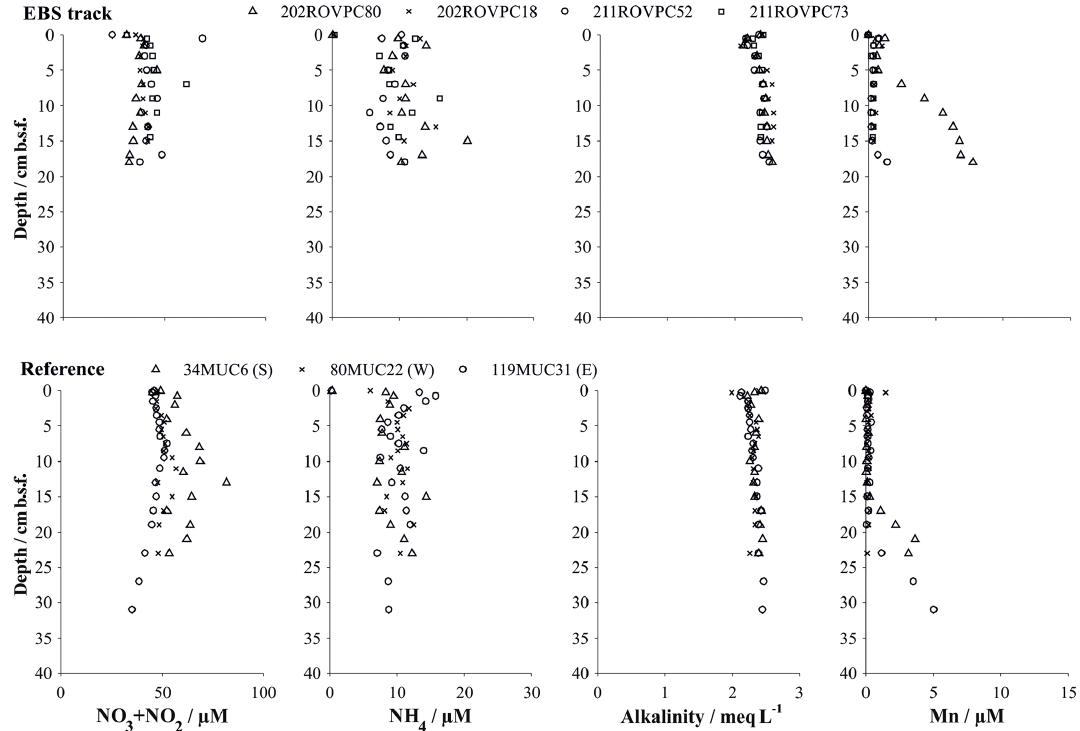
Figure 6. Solute profiles in multiple and box cores retrieved in various microhabitats. Symbols represent the measured values at the mean depth of the sediment layer sampled (summed NO 3 and NO 2 from Paul et al., 2018). Details on individual sampling stations can be found in